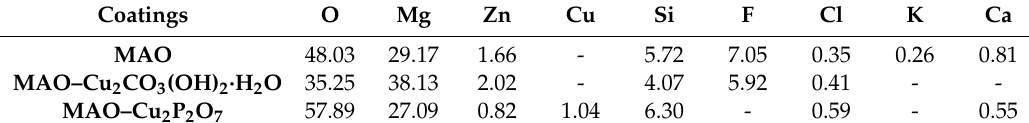
Table 4. EDS results of the three MAO coatings immersed in artificial seawater for 14 days (at. %).